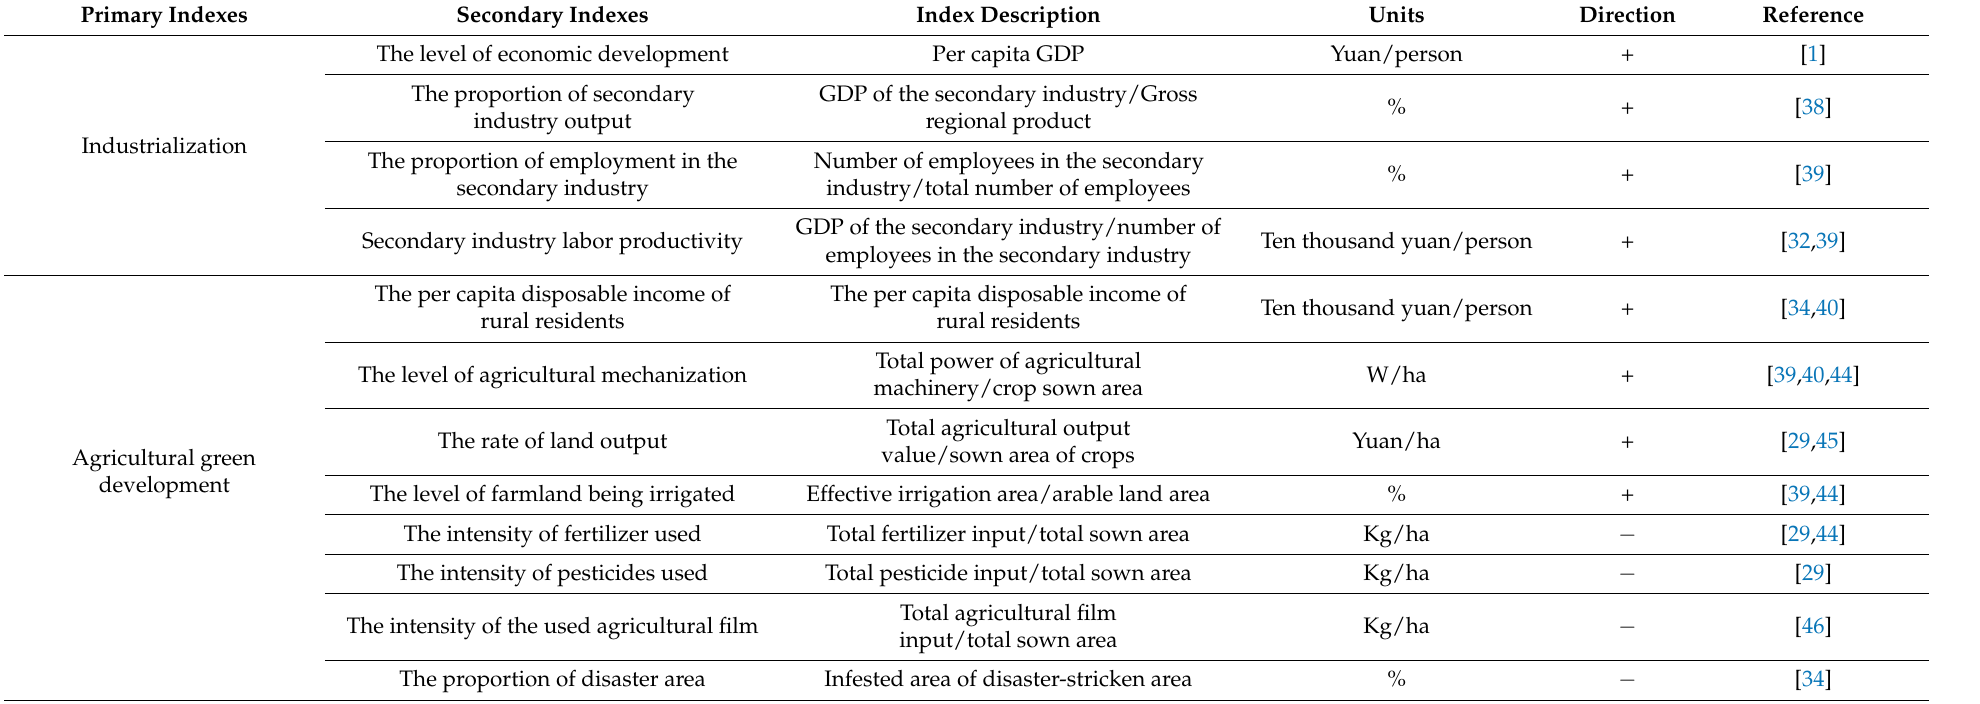
Table 1. Evaluation index system for the degree of coupling and coordination of industrialization and agricultural green